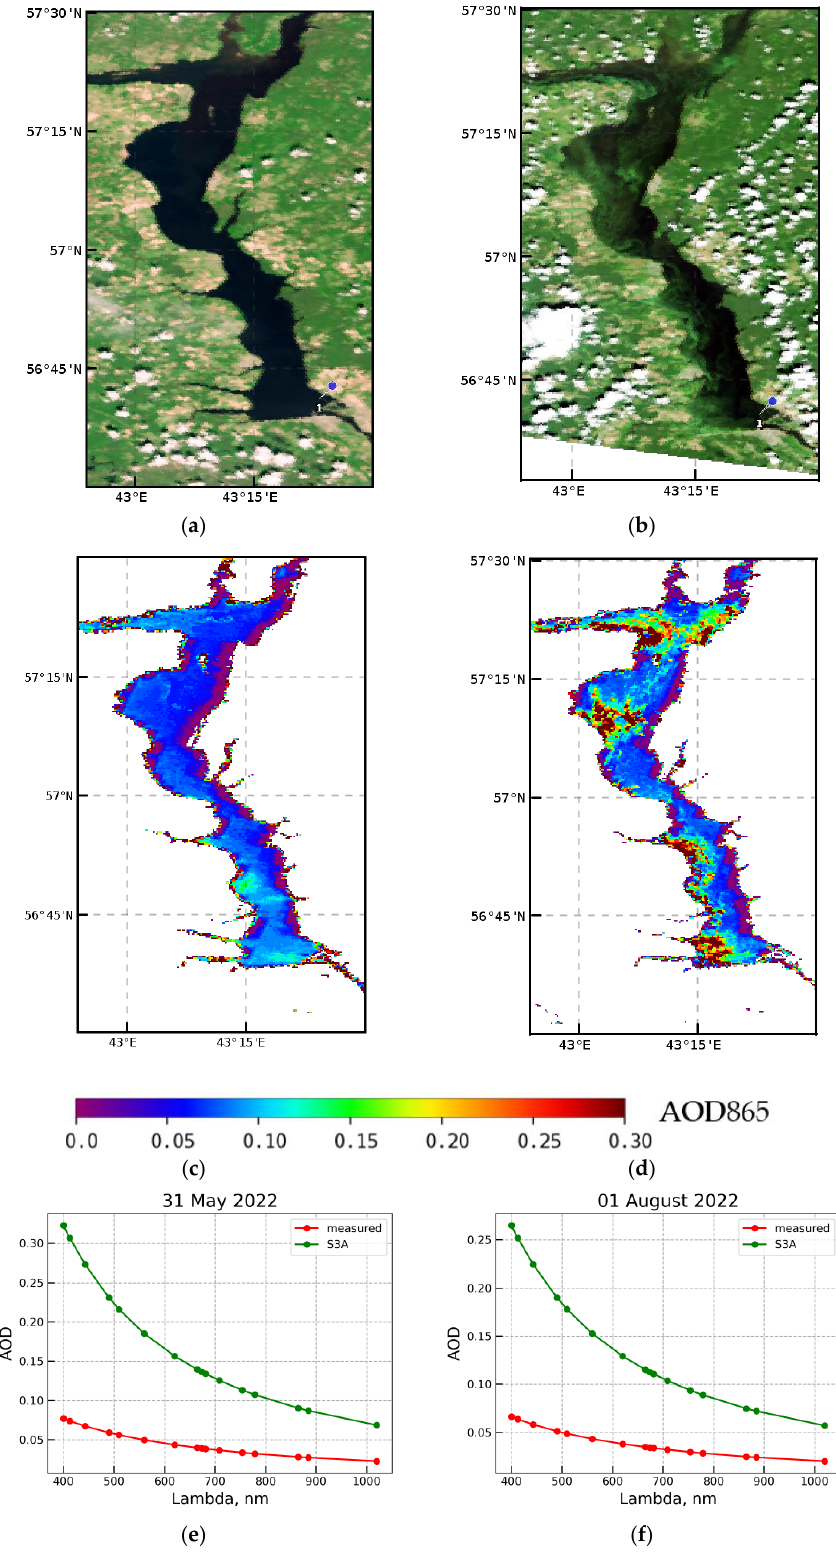
Figure 5. AOD865 according to OL_2_WFR: 31 May 2022 (left side), 1 August 2022 (right side); ( a , b ) are the RGB composite (665, 560, and 490 nm), AOD measurement stations are marked by pins; ( c , d ) are the distributions of AOD865 in the Gorky Reservoir; ( e , f ) are the OL_2_WFR AOD spectra (green lines) and measured AODs (red lines).